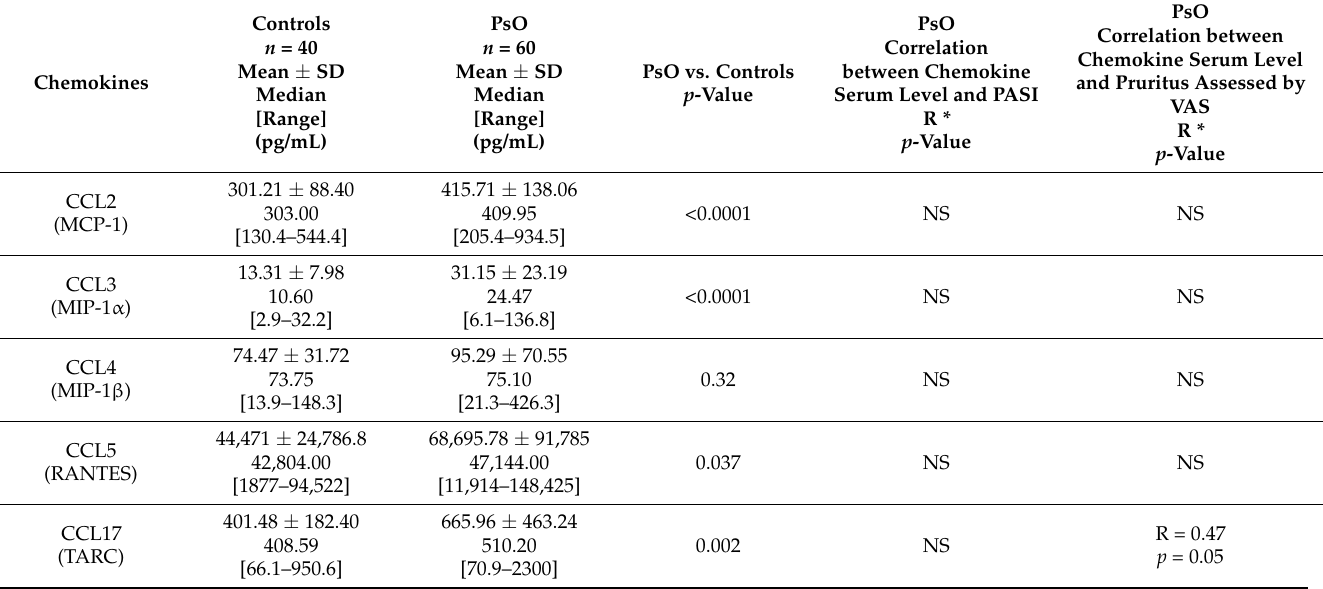
Table 1. Serum concentrations of chemokines in correlation with disease severity and pruritus intensity in